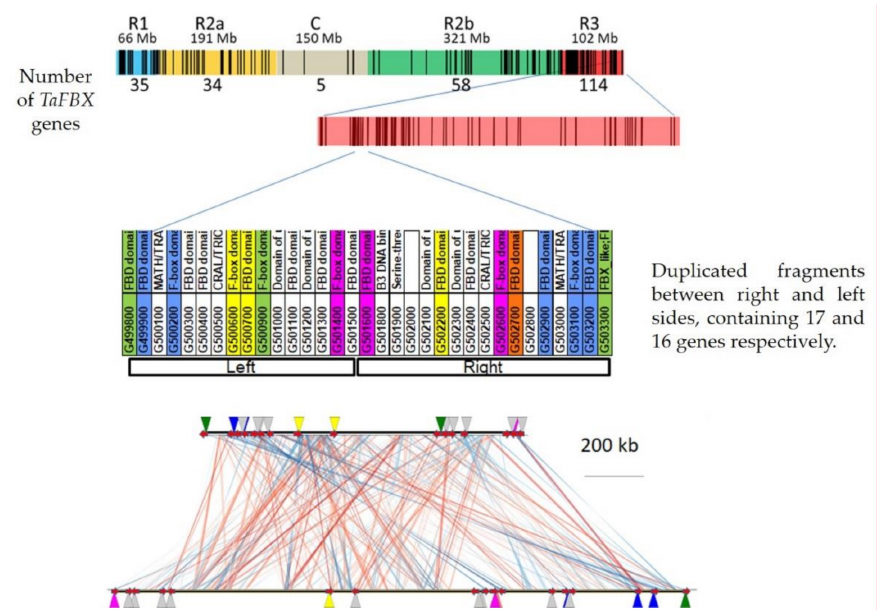
Figure 7. Evolutive study of a subregion of the chromosome 3B-R3 region (in red, on the top). We focused on a 3 Mb subregion, containing 33 genes including 15 TaFBX . The right region covers 1.09 Mb and carries 16 genes including seven TaFBX genes; whereas 17 genes (including eight TaFBX ) are carried by the 1.96 Mb left region. Using the ortholog groups defined by OrthoFinder, the TaFBX genes belonging to the same group were colored with the same color. Their protein sequences were analyzed using Pfam and their domains were specified along with their truncated names (i.e., “G499800” means “TraesCS3B02G499800”). The red lines on the bottom part represent direct duplications and the blue ones represent reverse